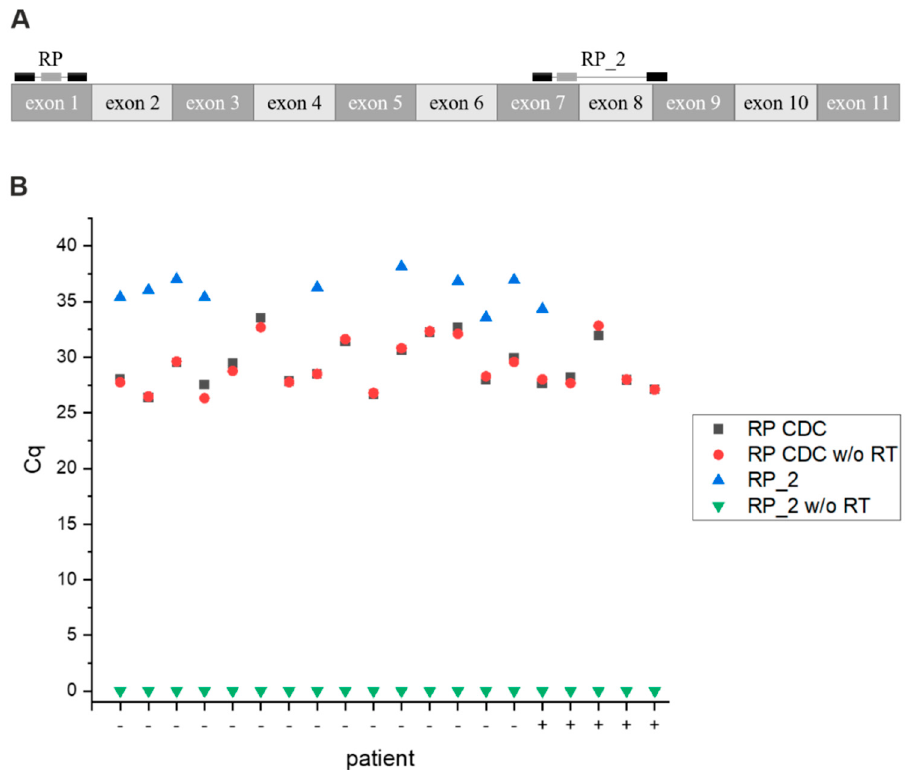
Figure 6. ( A ) For primer design, the sequence of the human mRNA of RNase P ; RPP30 (NM_006413.5) was used. Primers and TaqMan probes are indicated as black and grey boxes, respectively. ( B ) The RP_2 and the RP primer/probe set were evaluated with and without a reverse transcriptase step in 20 samples (15 negative and 5 positive), showing the specificity of the RP_2 primer/probe set for